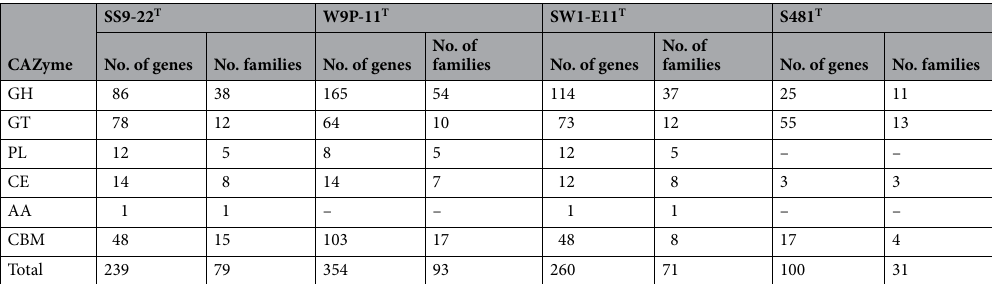
Table 6. The carbohydrate-active enzyme (from CAZy database) compositions of three novel strains SS9-22 T , W9P-11 T , SW1-E11 T , and a reference strain F. lutea S481 T . GH: glycoside hydrolase, GT: